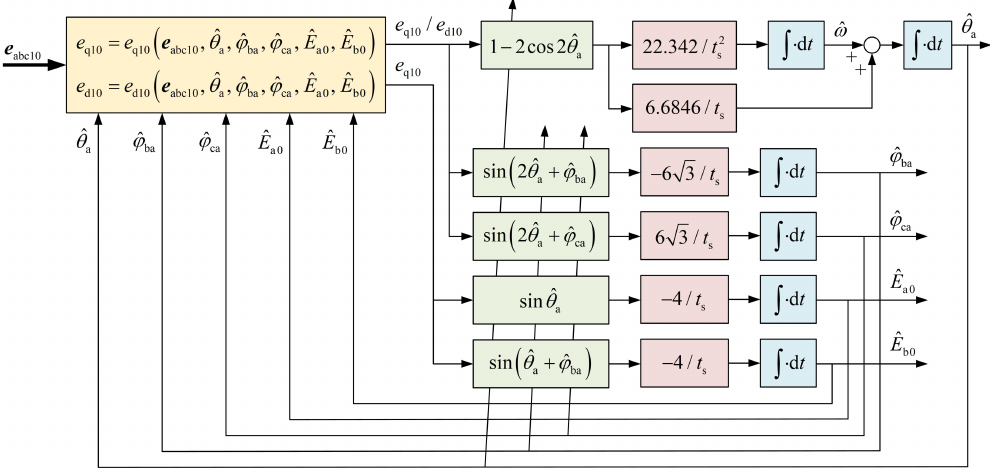
Figure 3. The FC&DC-DS in detection of the fundamental-voltage and DC-offset voltage parameters.